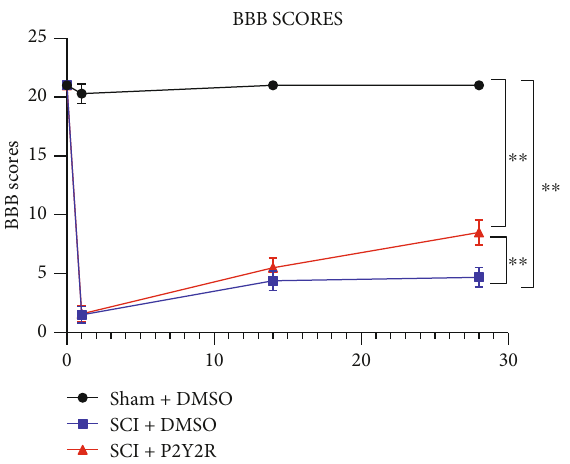
Figure 2: Recovery of motor function assessment. The recovery of the motor function was assessed with the BBB scoring method. After 2 weeks and 4 weeks of modeling, ∗∗ p < 0 : 01 compared with the sham+DMSO group; # p < 0 : 05 compared with the SCI +DMSO